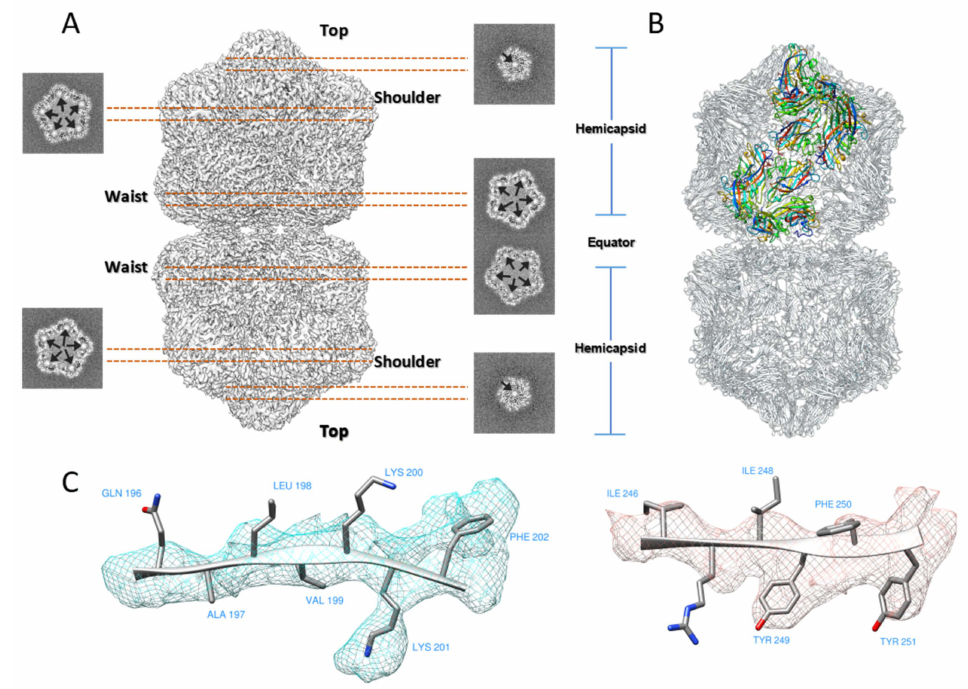
Figure 1. Cryo-EM structure of TbCSV Particles. ( A ) Surface representation of the D5-symmetrized EM map of TbCSV particle. From top to bottom, three types of di ff erent capsomers (top, shoulder, and waist) with five-fold or local five-fold symmetric capsomer are labeled. Horizontal slices cross the TbCSV map indicate density below the capsomers that might originate from DNA. ( B ) Complete model for all 110 CP subunits in the capsid, in which 11 CP subunits colored in rainbow indicate an asymmetric unit. ( C ) Representative areas with bulky sidechain densities used for model